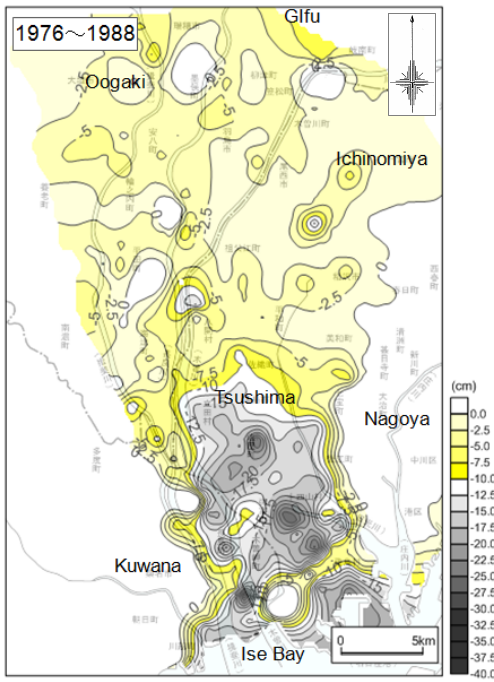
Figure 4. The thickness of alluvial clay layer and land subsidence area